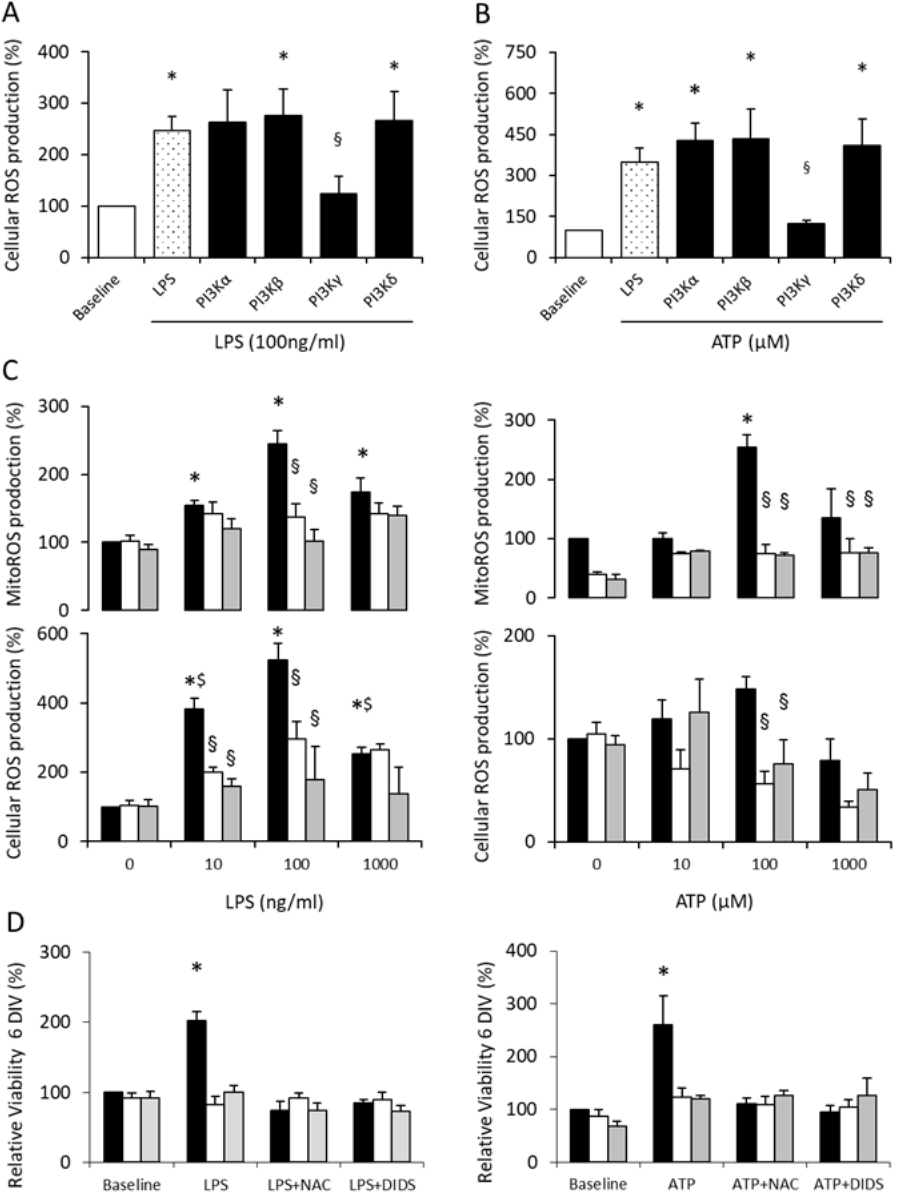
Figure 4. PI3K γ controls LPS- and ATP-induced microglial ROS production. ( A ) PI3K γ controls LPS-induced cellular ROS production in naïve microglia. Primary microglia derived from wild-type mice were seeded (30,000 cells/well) in a 96-well plate and pretreated for 60 min with selective inhibitors targeting lipid kinase activity of PI3K α (A66; 300 nM), PI3K β (TGX221; 200 nM), PI3K γ (AS605240; 1 µ M) or PI3K δ (IC87114; 2 µ M). Subsequently, cells were incubated with LPS (100 ng/mL) for 6 days. Cellular ROS production was measured by DCF fluorescence. n = 9, each, * § p < 0.05, * compared to untreated microglial cells (baseline, open columns); § compared to mock pretreated microglial cells (LPS, dotted columns). ( B ) PI3K γ controls ATP-induced cellular ROS production in naïve microglia. Primary microglia derived from wild-type mice were seeded (30,000 cells/well) in a 96-well plate and pretreated for 60 min with selective inhibitors targeting lipid kinase activity of PI3K α (A66; 300 nM), PI3K β (TGX221; 200 nM), PI3K γ (AS605240; 1 µ M) or PI3K δ (IC87114; 2 µ M). Subsequently, cells were incubated with ATP (100 µ M) for 6 days. Cellular ROS production